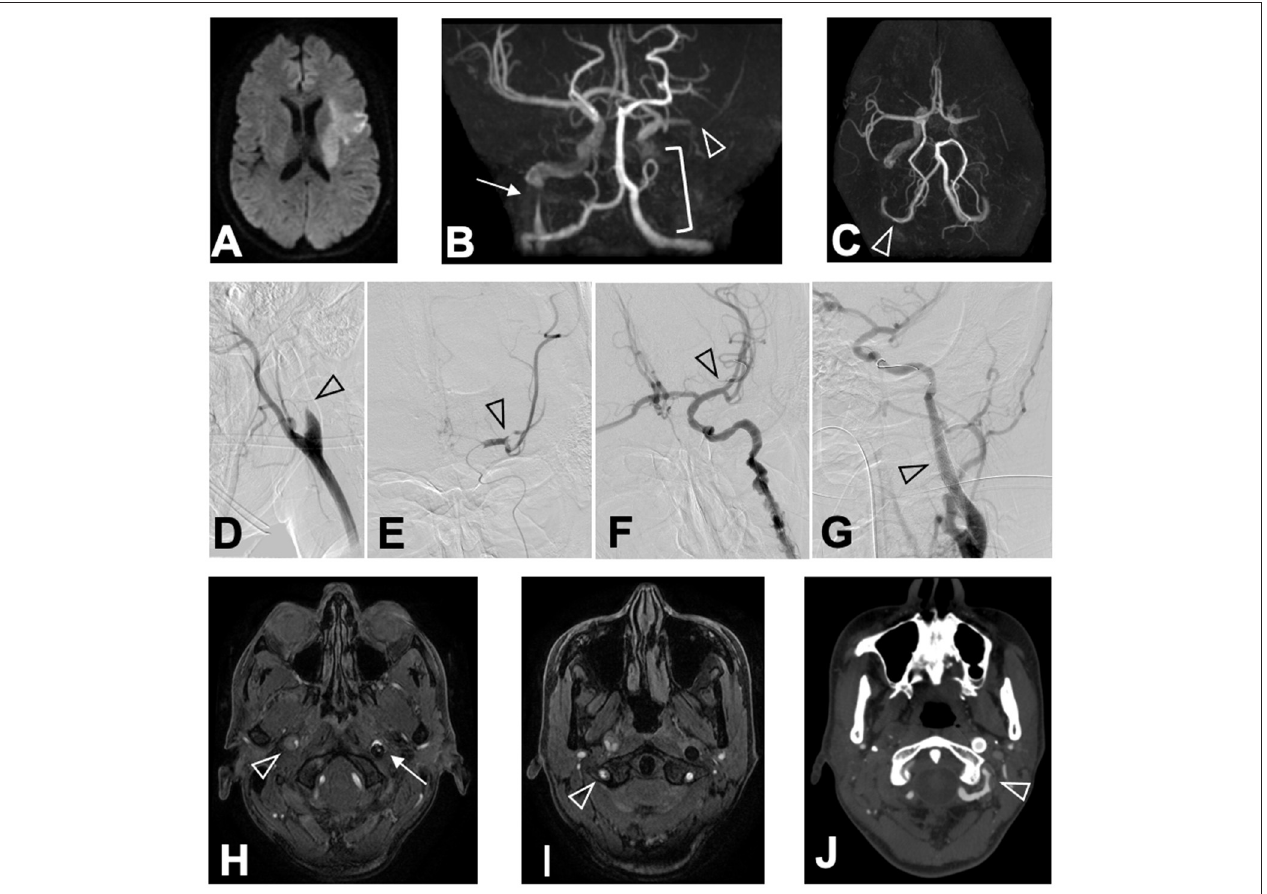
FIGURE 1 | Chronological changes of CCAD lesions. MRI (DWI) on arrival revealed (A) hyperintense lesions in the left frontal lobe, the left temporal lobe, and the left corona radiata in DWI sequence. MRA revealed (B) M2 segment occlusion of the left MCA (arrowhead), occlusion of the left ICA (bracket), and severe stenosis of the right ICA (arrow) in coronal view, and (C) luminal irregularity of the V3 segment of the right VA (arrowhead) in basal view. Angiography conducted at ED revealed (D) the left ICA occlusion (arrowhead), (E) occlusion of the M2 segment of the left MCA (arrowhead), (F) recanalized left MCA after thrombectomy (arrowhead), and (G) stented left ICA after angioplasty (arrowhead). MRA performed 24h after hospitalization revealed (H) an intimal flap in the right ICA (arrowhead), the stented left ICA (arrow), and (I) intimal flap in the right VA (arrowhead). CTA performed 15 days after hospitalization revealed (J) luminal irregularity of the V3 segment of the left VA